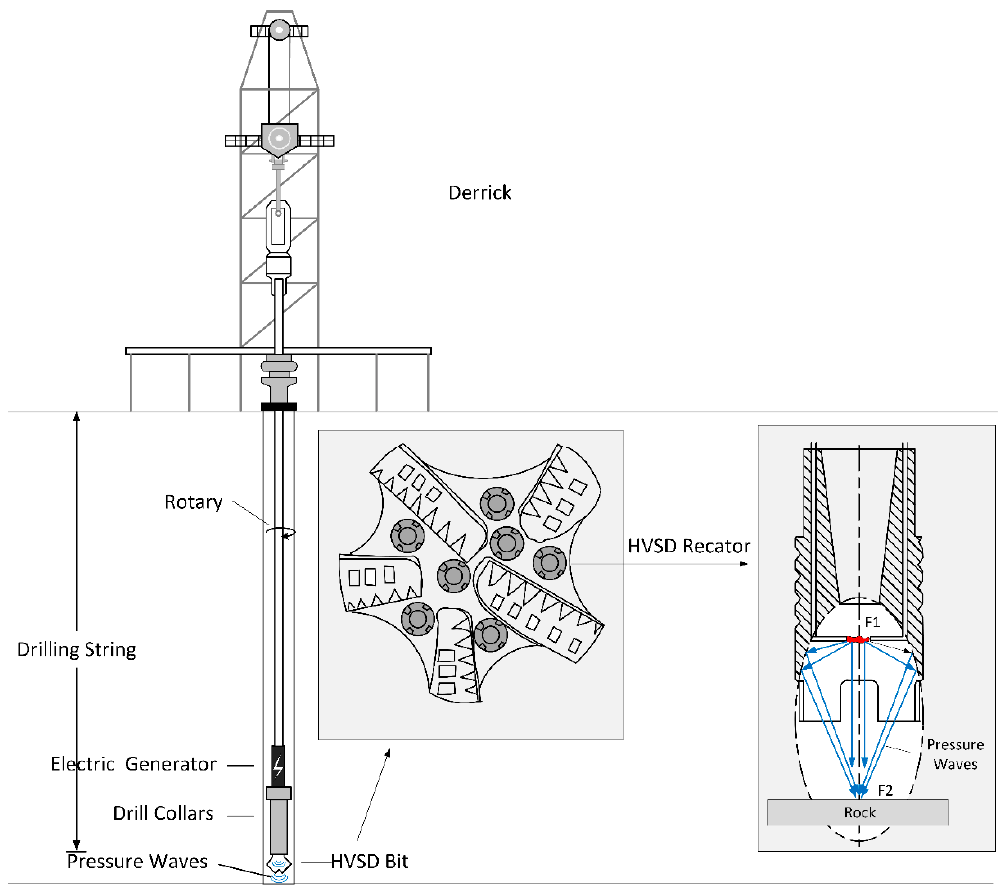
Figure 1. Conceptual design of drilling system based on the high voltage spark discharge.